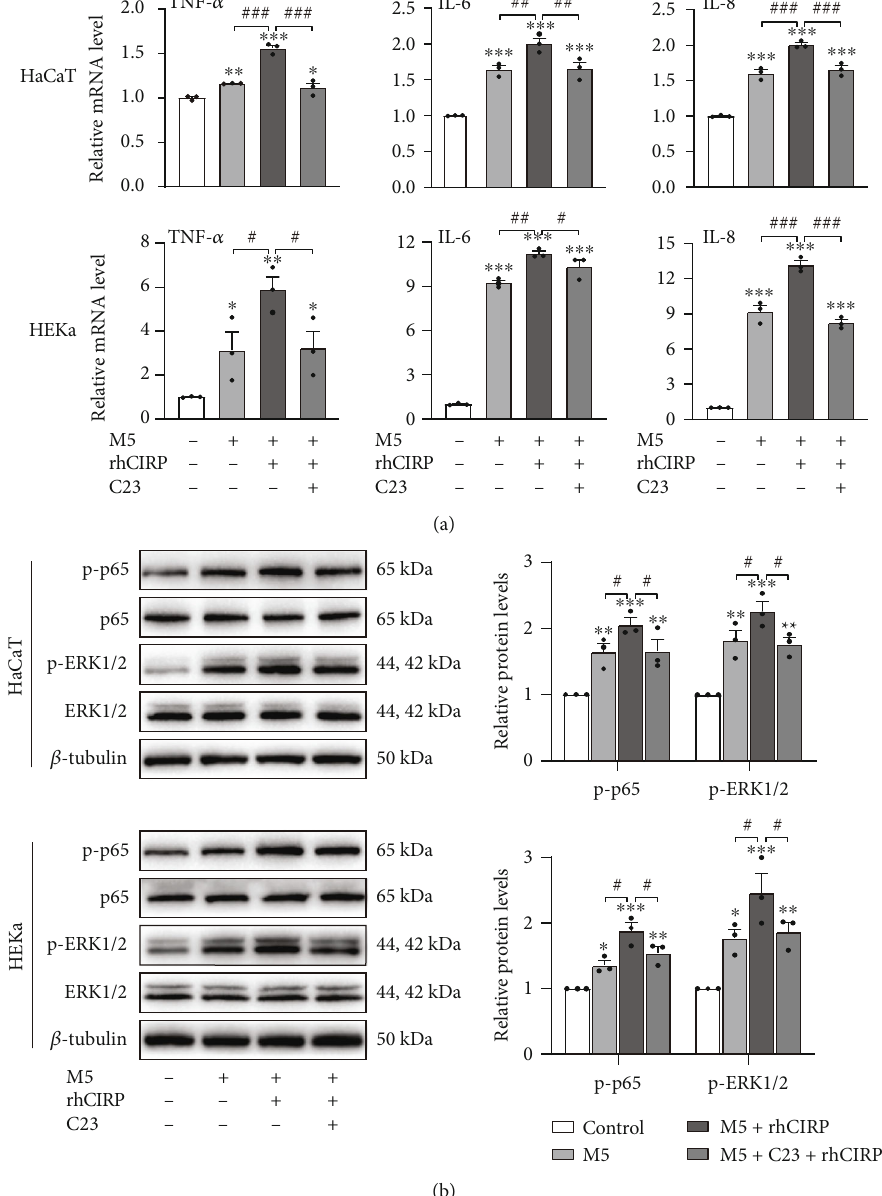
Figure 5: C23 inhibited the eCIRP-induced upregulation of proin fl ammatory cytokine expression and activation of signaling pathways in M5-stimulated psoriatic keratinocytes. (a) C23 inhibited TNF- α , IL-6, and IL-8 production in psoriatic keratinocytes stimulated with rhCIRP. Cells were stimulated with M5 for 24 hours, pretreated with 1 μ g/ml C23 for 30 minutes, and then incubated with 1 μ g/ml rhCIRP for 1 hour. RNA was extracted for analysis by qRT-PCR. (b) C23 inhibited the phosphorylation of NF- κ B p65 and ERK1/2 in psoriatic keratinocytes stimulated with rhCIRP. Cells were stimulated with M5 for 24 hours, pretreated with 1 μ g/ml C23 for 30 minutes, and then incubated with 1 μ g/ml rhCIRP for 1 hour. Cells were lysed for western blot analysis of the indicated proteins. The phosphorylation of NF- κ B p65 and ERK1/2 was analyzed by western blot analysis. Data are expressed as the mean ± SEM . n = 3 /group. ∗ P < 0 : 05 , ∗∗ P < 0 : 01 , and ∗∗∗ P < 0 : 001 vs. control; # P < 0 : 05 , ## P < 0 : 01 , and ### P < 0 : 001